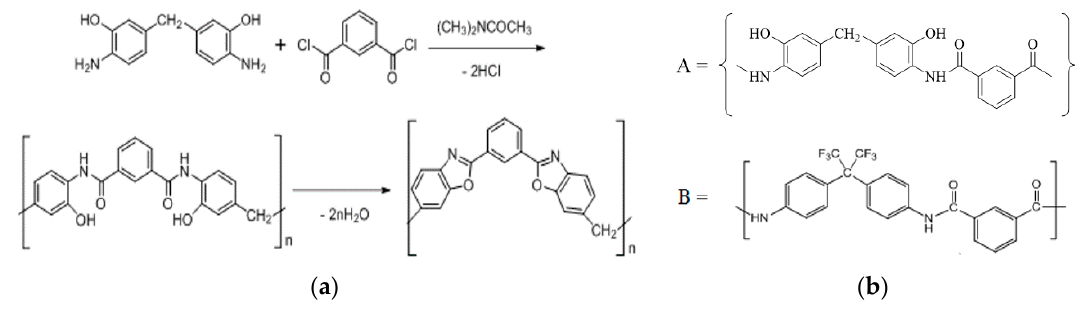
Figure 1. Scheme of transformation of poly( o -hydroxyamide) (POA) to poly(benzoxazoles) (PBO) during thermal cyclodehydration ( a ) and structural formulae of the synthesized copolymers ( b ).